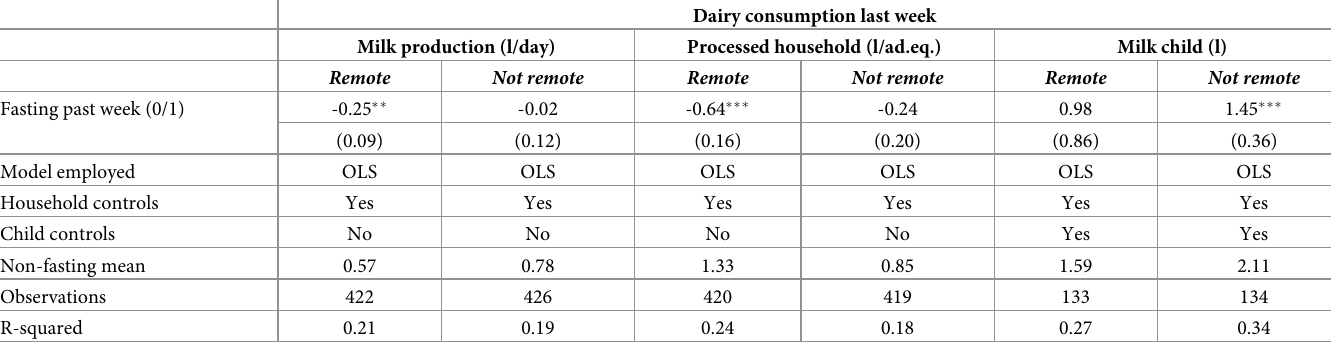
Table 12. Heterogeneity in consumption adaptation strategies by remoteness to Addis Ababa. Dairy consumption last week Milk production (l/day) Processed household (l/ad.eq.) Milk child (l) Remote Not remote Remote Not remote